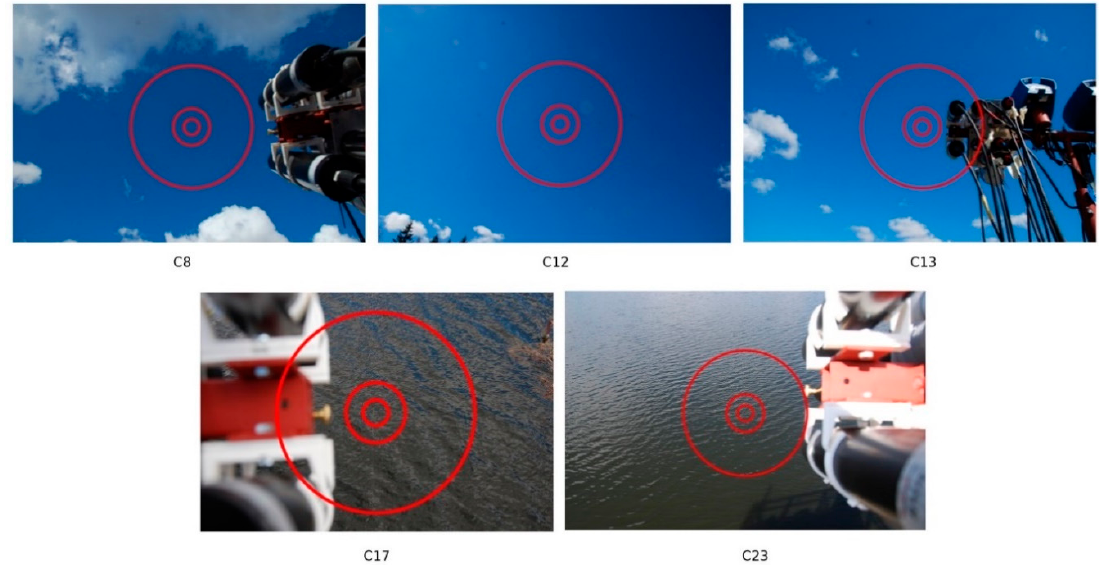
Figure 7. Photographs of radiance targets used in the intercomparison analysis. The circles denote approximate FOV of WISP-3 (smallest), RAMSES, and HyperOCR (largest).